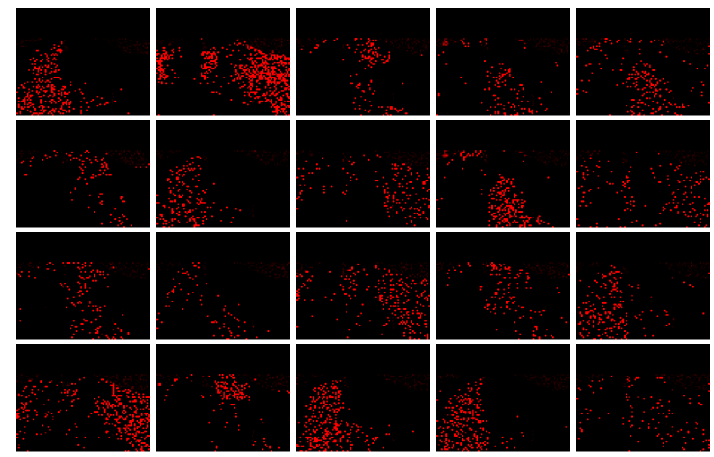
Figure 12. Twenty latent motion regions discovered by RTM-GS on longer burn-in time.